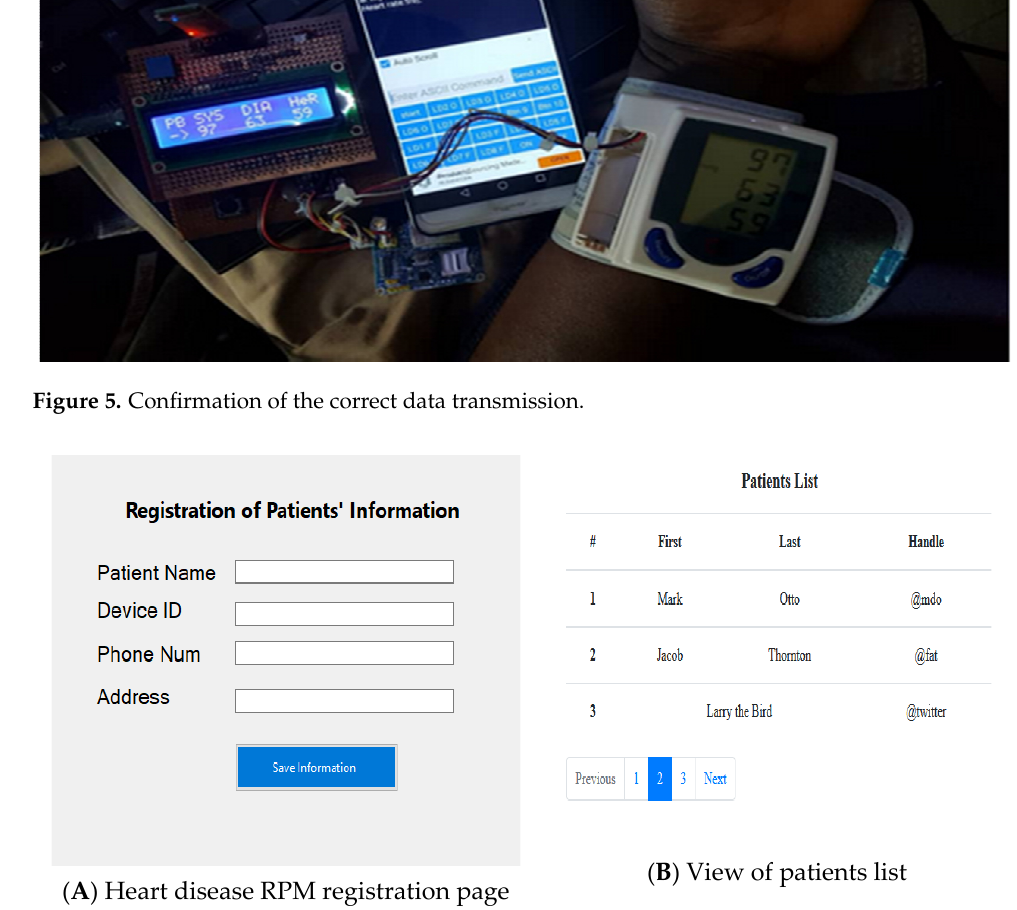
Figure 7. Patient’s records view from the